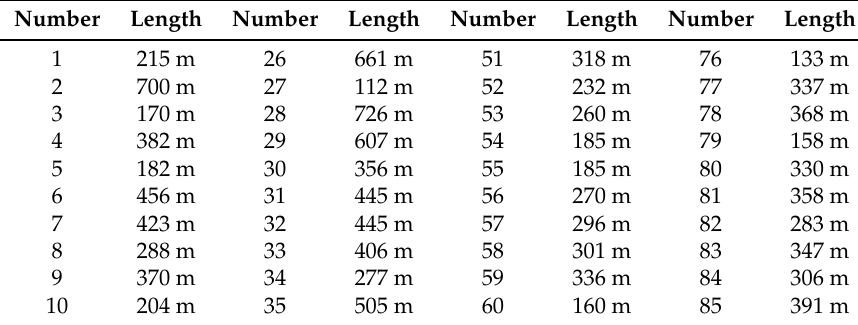
Table A1. Cell length of Beijing’s second ring